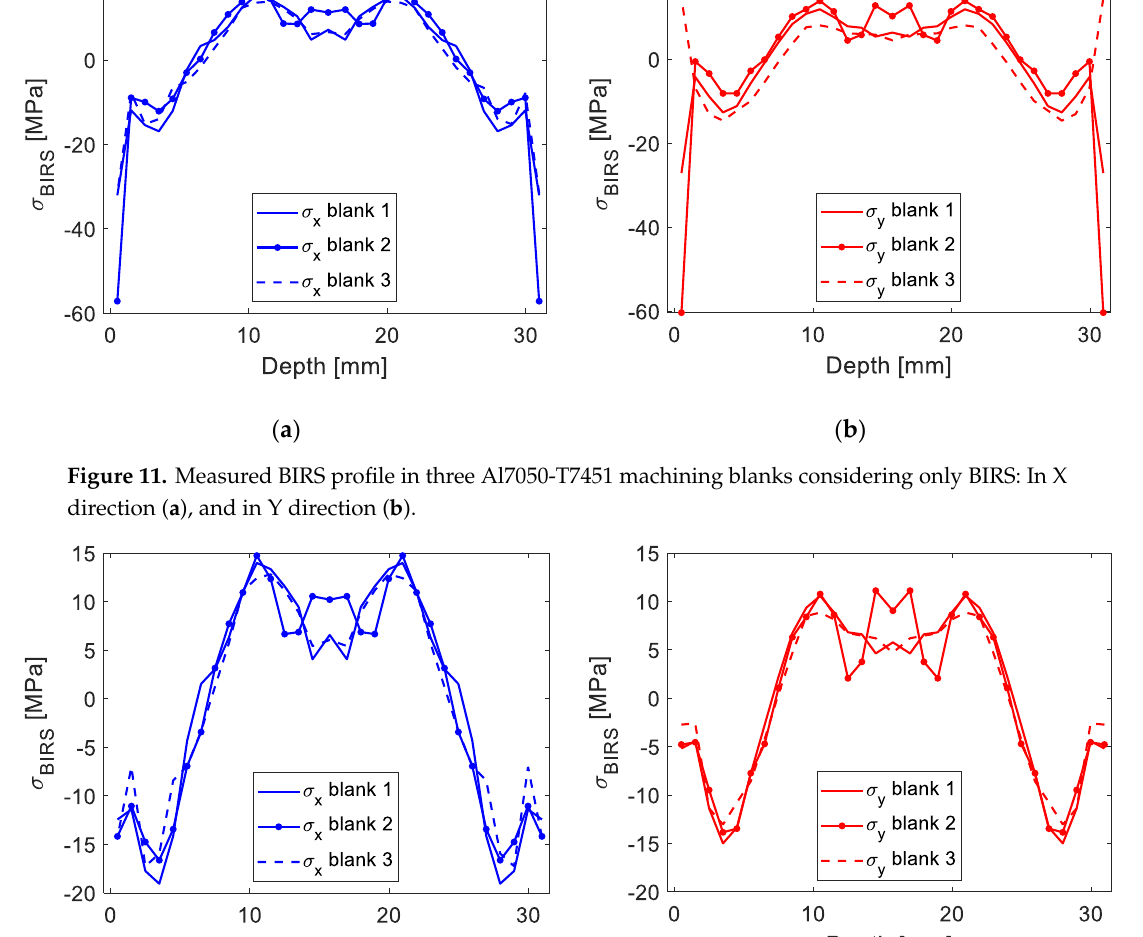
Table 3. Cutting parameters of MIRS measured in Al7050-T7451 face milled surfaces by incremental hole drilling.